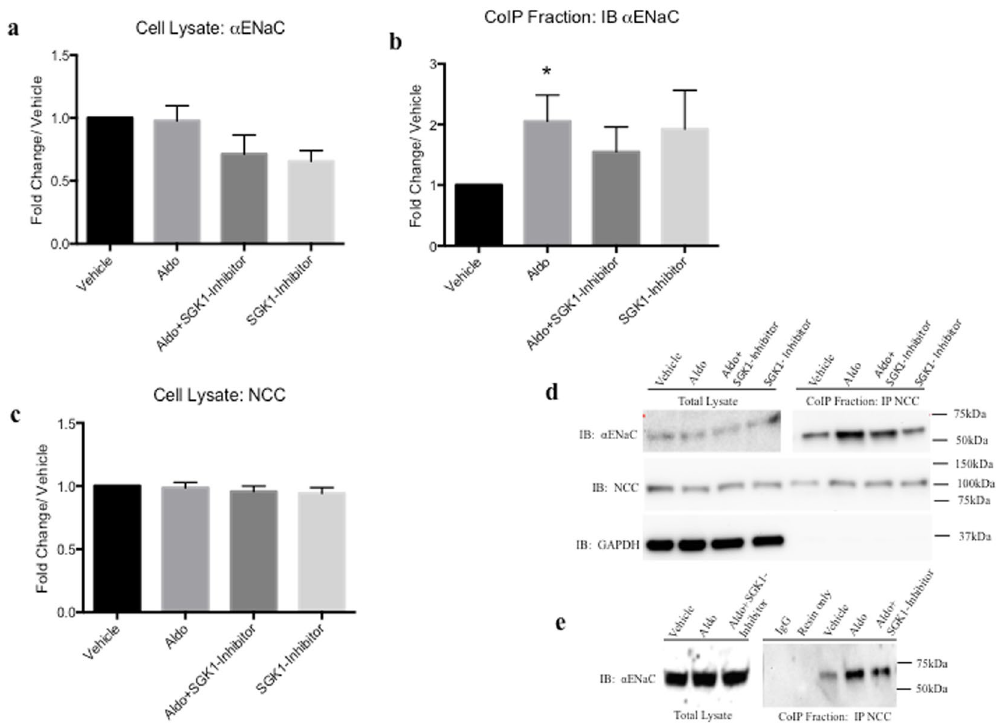
Figure 2. Coimmunoprecipitation demonstrated increased association of NCC and α ENaC in mouse distal convoluted cells with Aldo stimulation. Total cell lysate of mDCT15 cells were immunoprecipitated (IP) with anti-NCC antibody and probed with α ENaC antibodies in vehicle, Aldo-treated (100 nM, 48 hrs), Aldo + SGK1 inhibitor (GSK690394, 6 uM, 60 min) or with SGK1 inhibitor alone. ( a ) mDCT15 total lysate probed with α ENaC. ( b ) mDCT15 cell lysate IP with NCC and probed with α ENaC antibody ( c ) mDCT15 cell lysates probed with NCC following respective treatments ( d ) Representative blots for CoIP experiments. Blots were cut to assay for multiple antibodies. ( e ) No antibody lanes contain lysate with resin only. Separation in images shown with a space. Data represented as mean ± SEM, n = 5; Wilcoxin Signed-Rank, * p <